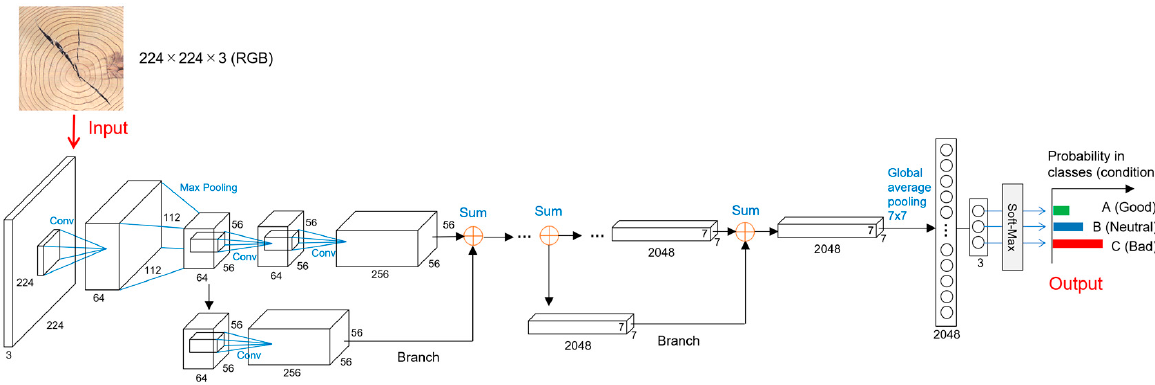
Figure 7. CNN structure for crack severity evaluation.